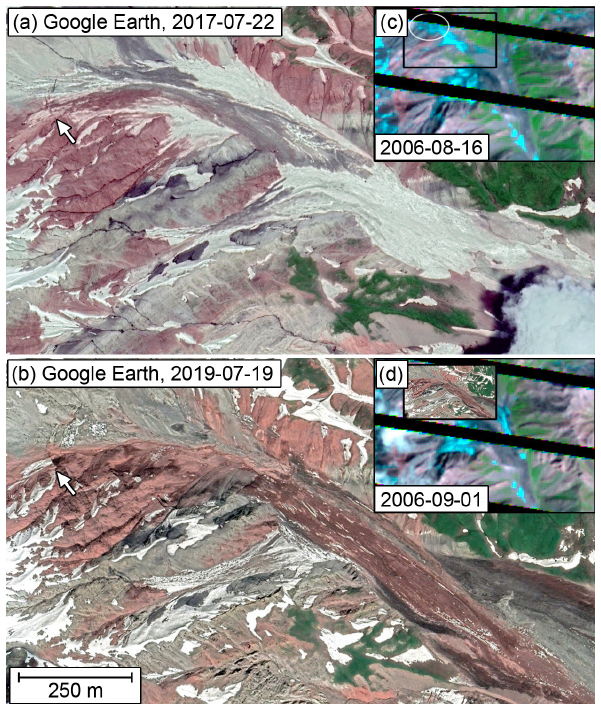
Figure 8. Imagery from before (a) and after (b) the rock-ice avalanche sha-19 that caused the disappearance of a small glacier in a side valley of the Shaklysu river. White arrows indicate the detach- ment scarp. (c, d) At the same place (white circle) an earlier rock- ice avalanche (sha-06) happened. The black box in the inset corre- sponds to the outline of the main images. (a, b) © Google, Maxar ical Survey.